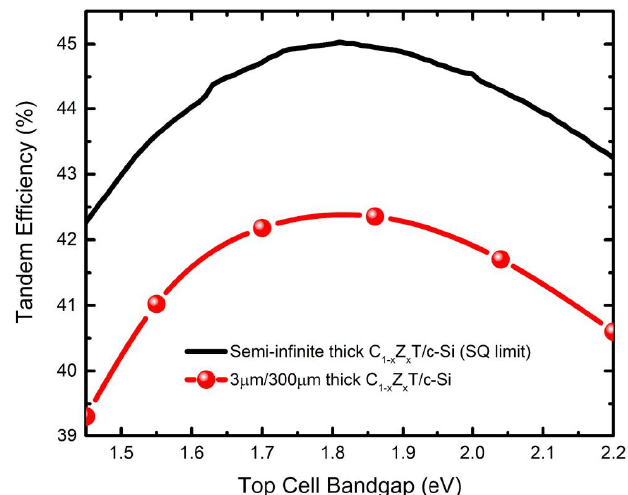
Figure 1. Maximum achievable conversion e ffi ciency for C 1 − x Z x T / c-Si tandem cell calculated using the 4T tandem design. The two cases shown correspond to the SQ limit, which assumes semi-infinite absorber thicknesses and zero loss due to parasitic absorption, and a more practical limit, assuming finite thicknesses of 3 and 300 µ m for the C 1 − x Z x T and c-Si absorbers, respectively, and the external reflection loss (i.e., due to air–C 1 − x Z x T interface) is